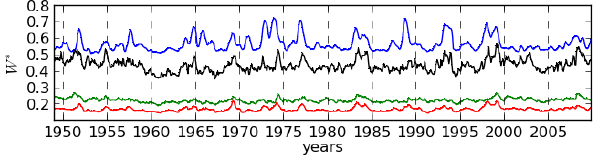
Fig. 1. Comparison of the evolution of the threshold W ∗ for the RPCA graph (68 components) and grid-based graph (with 2562 nodes) obtained for fixed densities. Blue line: 2562 nodes, ρ =0.005, black line: 68 components, ρ =0.005, red line: 2562 nodes, ρ =0.142, green line: 68 components, ρ =0.142.